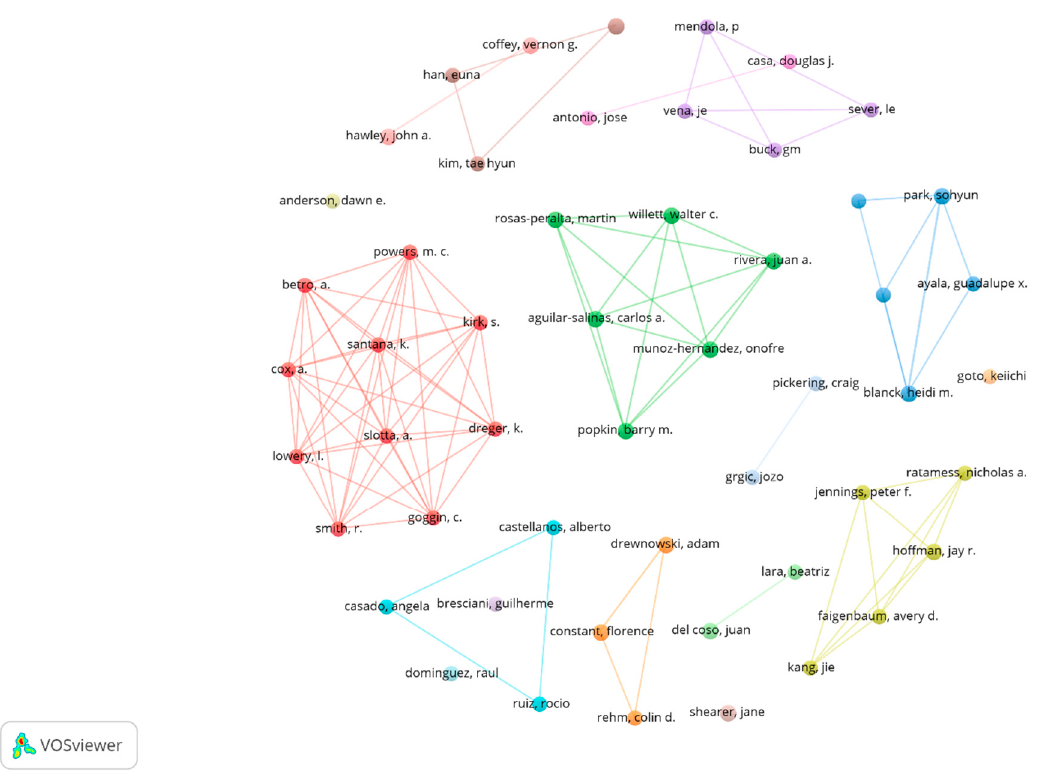
Figure 2. Co-authors graph on coffee/caffeine and sport (only prolific authors). The fragmentation level is reinforced at the organization level. The graph in Figure 3 shows 46 organizations with a minimum participation of two articles, for a total of 276 organizations (there are 230 organizations with only one contribution on coffee/caffeine and sport studies). This strengthens the identification of an actor’s configuration, based on competitive interaction or structural equivalence [61–63].